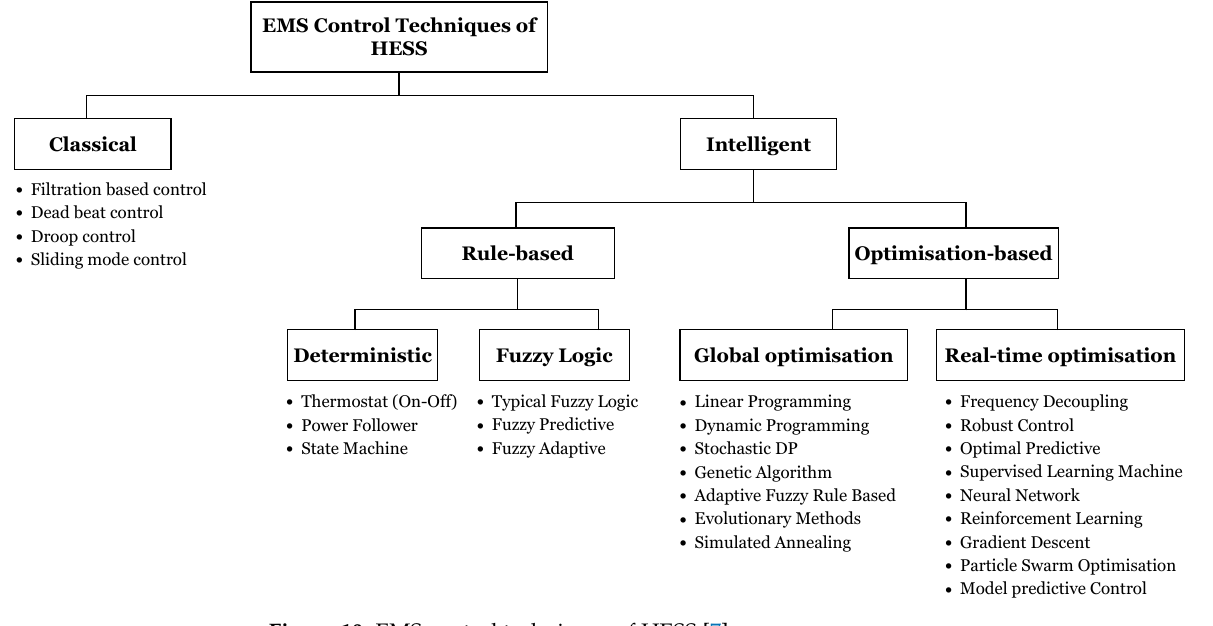
Figure 10. EMS control techniques of HESS [7]. Table 8. A summary of the main real-time EMS control